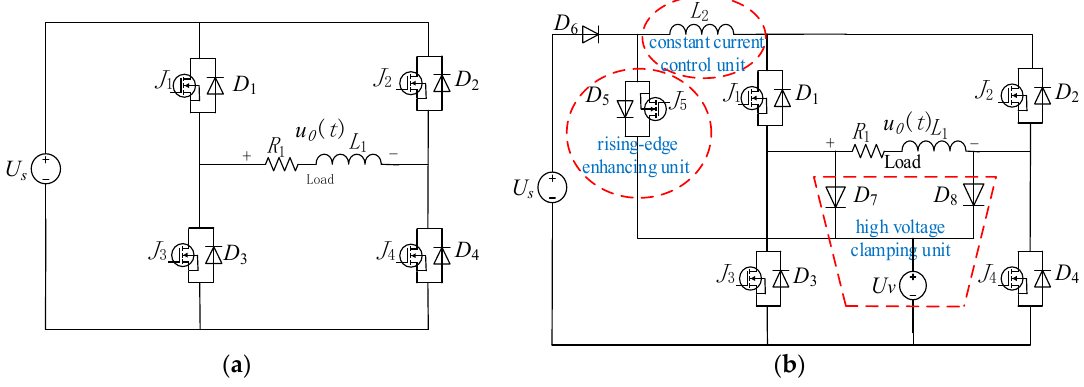
Figure 1. Circuit model: ( a ) Traditional full bridge circuit model. ( b ) Constant current and voltage clamping control circuit.